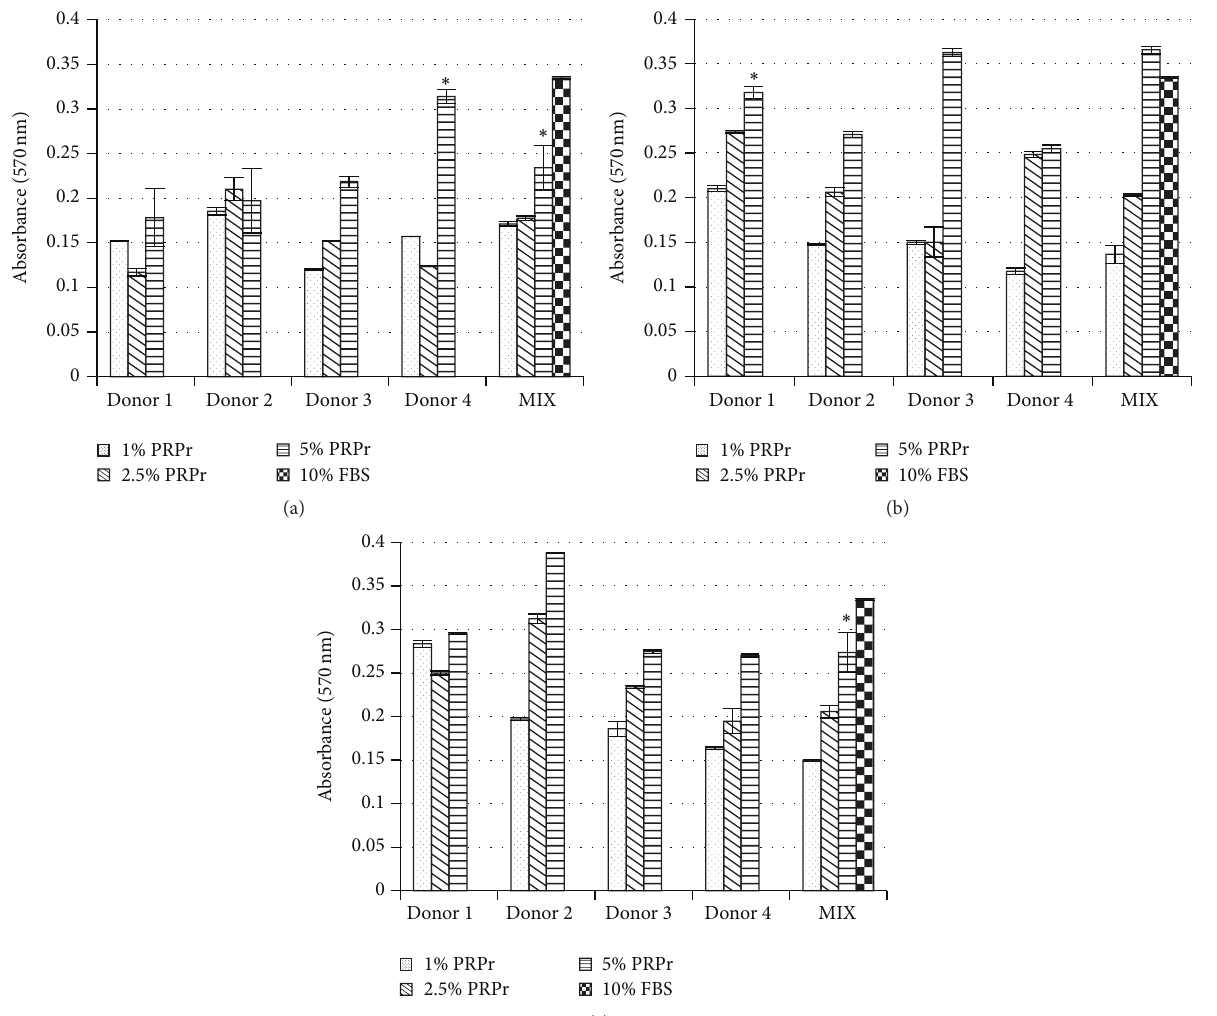
Figure 4: BM-MSC viability in PRPr obtained with different anticoagulant. Absorbance at 570nm was measured after MTT viability assay of cells cultivated in different PRPr concentrations, obtained with EDTA (a), SC (b), and ACD (c), as well as 10% FBS (control). Data are expressed as mean, and error bars correspond to standard error. “ ∗ ” corresponds to statistical similarity with 10% FBS ( 𝑝 > 0.05